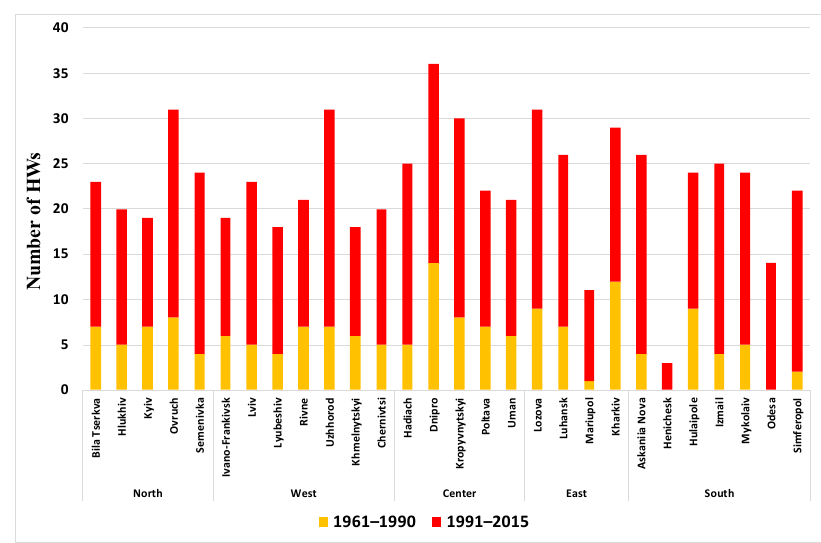
Figure 2. Number of HWs in Ukraine in the years 1961–2015.